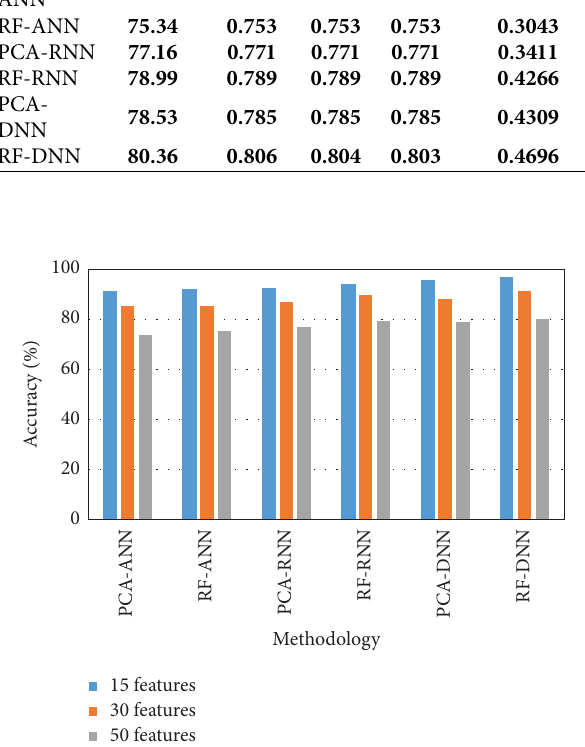
Figure 14: Graphical representation of the proposed model for driver identifcation in terms of accuracy with diferent number of